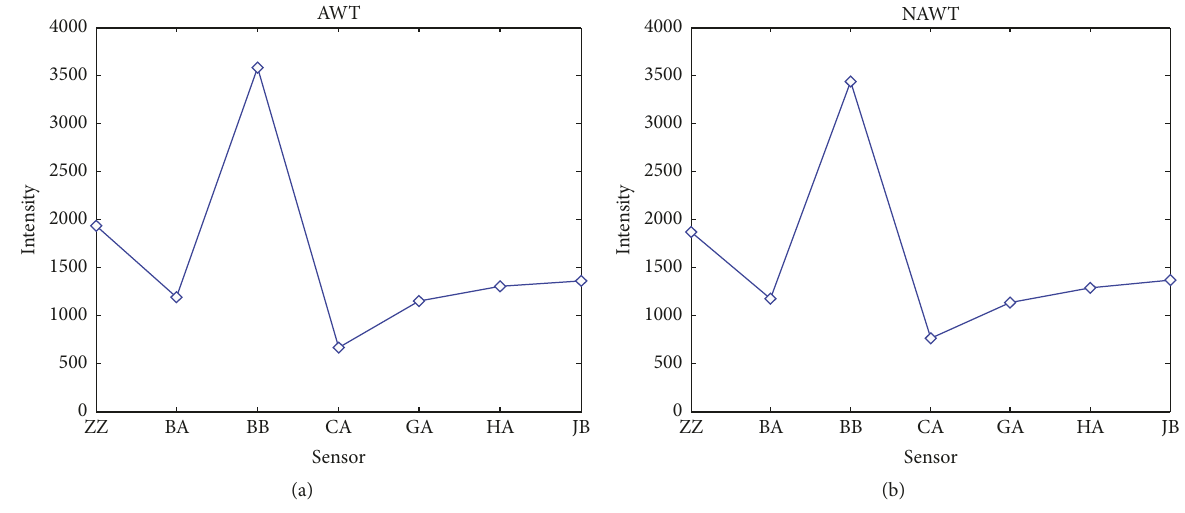
Figure 1: The average responses of 7 sensors to AWT and NAWT.